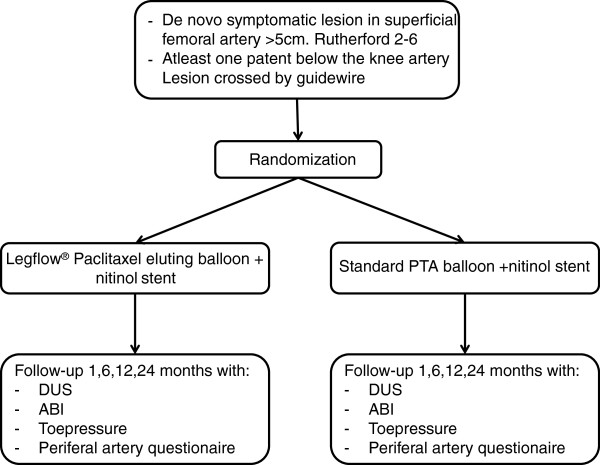
Flow diagram for inclusion and treatment. Legend: DUS, duplex ultrasound; ABI, Ankle-Brachial index.